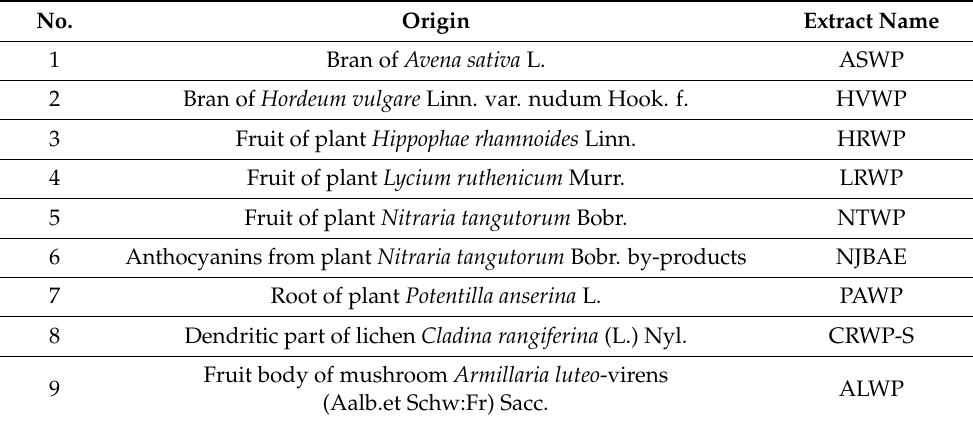
Table 1. Origin of extracts and their